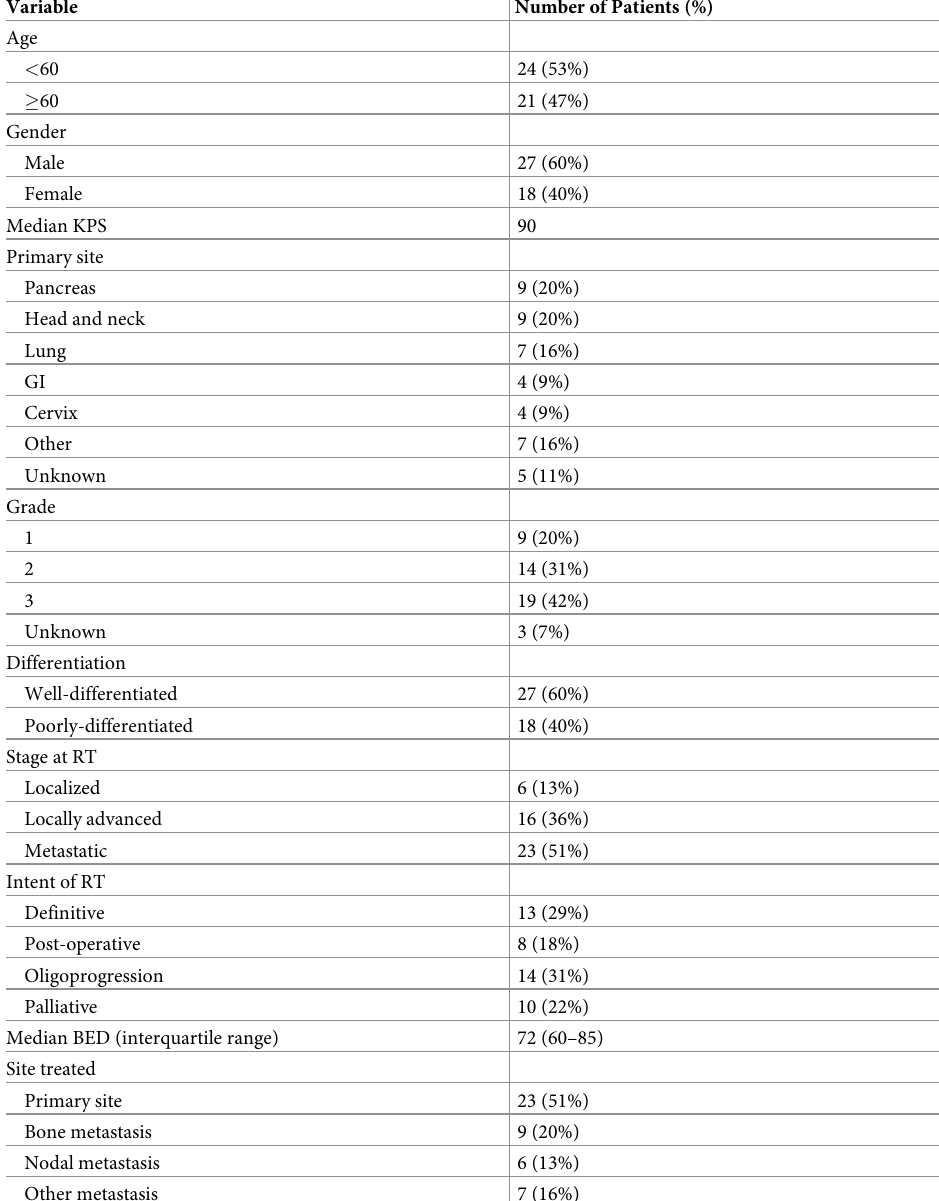
Table 1. Baseline and treatment characteristics of patients who received high-dose radiation (n =